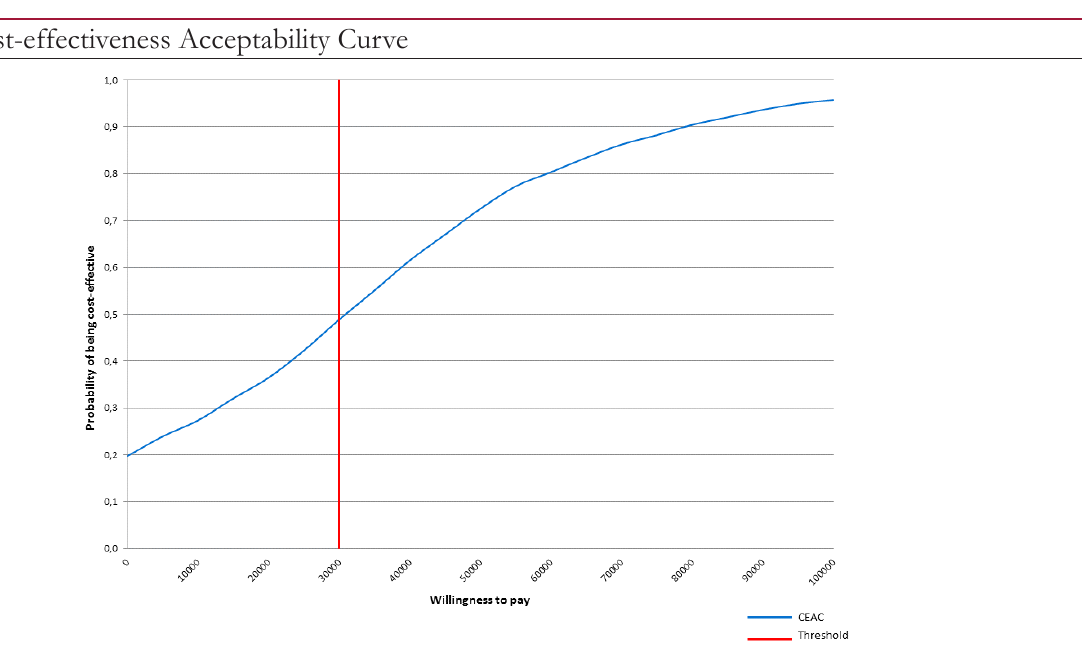
Figure 3. Cost-effectiveness Acceptability